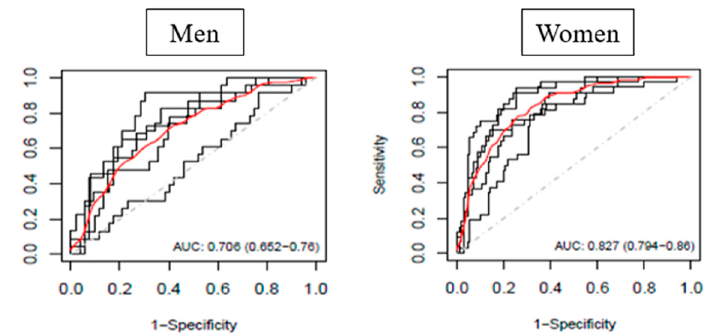
Figure 4. ROC curves for LASSO using 5-fold cross-validation in the analysis of the combination of facial feature and facial color. Black lines show individual ROC curves for 5-fold cross-validation,